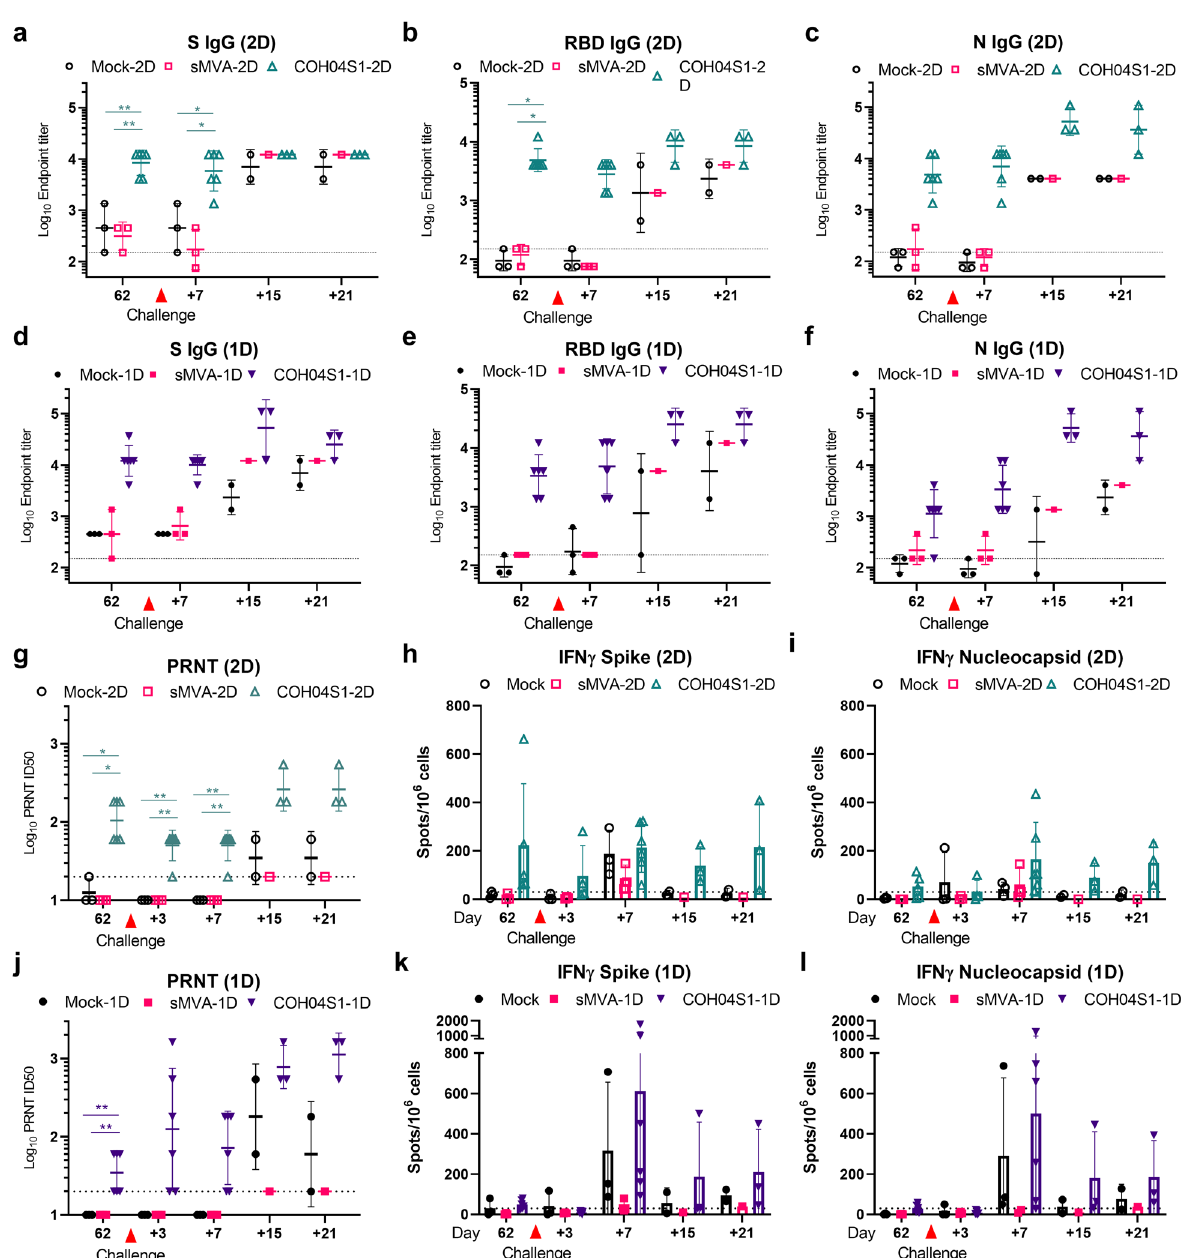
Fig. 6 SARS-CoV-2-speci fi c post-challenge immune responses in COH04S1-vaccinated NHP. SARS-CoV-2-speci fi c humoral and cellular immune responses were measured at the indicated days post-challenge in COH04S1-2D and COH04S1-1D-vaccinated NHP and mock- vaccinated and sMVA vector control animals and compared to pre-challenge immunity assessed in these groups. Panels a – f show S, RBD and N antigen-speci fi c binding antibody titers evaluated by ELISA. Panels g , j show NAb titers measured by PRNT assay against SARS-CoV-2 USA- WA1/2020 reference strain. Lines in a – f , g , j represent geometric means ± geometric s.d. Dotted lines indicate lower limit of detection (LOD). Values below the LOD are indicated as ½ LOD. Panels h – i , k – l show IFN γ -expressing S- and N-speci fi c T cell responses measured by Fluorospot assay. Bars represent mean values, lines represent ± s.d. Dotted lines indicate the arbitrary positive threshold of 30 spots/10 6 cells. Two-way ANOVA followed by Tukey ’ s multiple comparison test was used. Time-points with <3 samples/group (day 15 and day 21 post challenge) were excluded from the statistical evaluation. *0.05 < p < 0.01, **0.01 < p < 0.001, ***0.001 < p < 0.0001, **** p < 0.0001. (Figs. 6a – f, g, j), indicating induction of robust post-challenge responses were detected post-challenge in control animals, with anamnestic immune responses. This post-challenge booster effect the exception of elevated frequencies of S- and N-speci fi c IFN γ - on SARS-CoV-2-speci fi c humoral immunity appeared more pro- expressing T cell responses in mock-vaccinated control animals at nounced in COH04S1-1D-vaccinated NHP than in COH04S1-2D- day 7 post challenge (Figs. 6h, k, i, l). vaccinated NHP, which may be a result of the lower pre-challenge Compared to antibodies measured pre-challenge in COH04S1- responses in the 1D vaccine group compared to the 2D vaccine vaccinated NHP, boosted titers of S, RBD, and N antigen-speci fi c group. In addition, binding antibodies and NAb measured at day binding antibodies and PRNT-assayed NAb were measured in 15 and 21 post-challenge in COH04S1-vaccinated NHP generally COH04S1-vaccinated animals at day 15 and 21 post challenge npj Vaccines (2022) 7 Published in partnership with the Sealy Institute for Vaccine